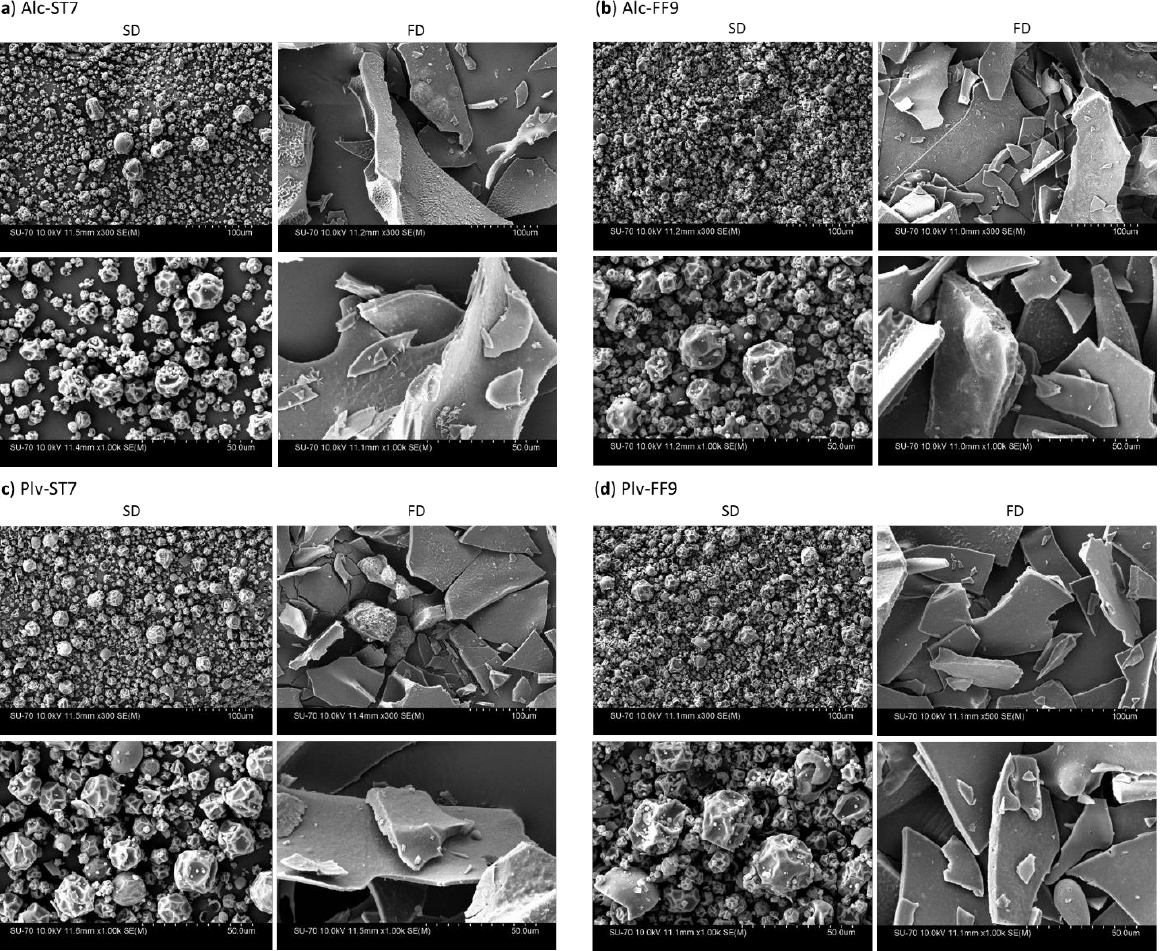
Figure 2. Scanning electron micrographs of whey protein hydrolysed using ( a ) Alcalase ® under pH-stat at pH 7.0 (Alc-ST7), ( b ) Alcalase ® under free-fall pH 9.0 (Alc-FF9), ( c ) Prolyve ® under pH-stat at pH 7.0 (Plv-ST7) and ( d ) Prolyve ® under free-fall pH 9.0 (Plv-FF9) where powders were obtained from spray-drying (SD) and freeze-drying (FD).